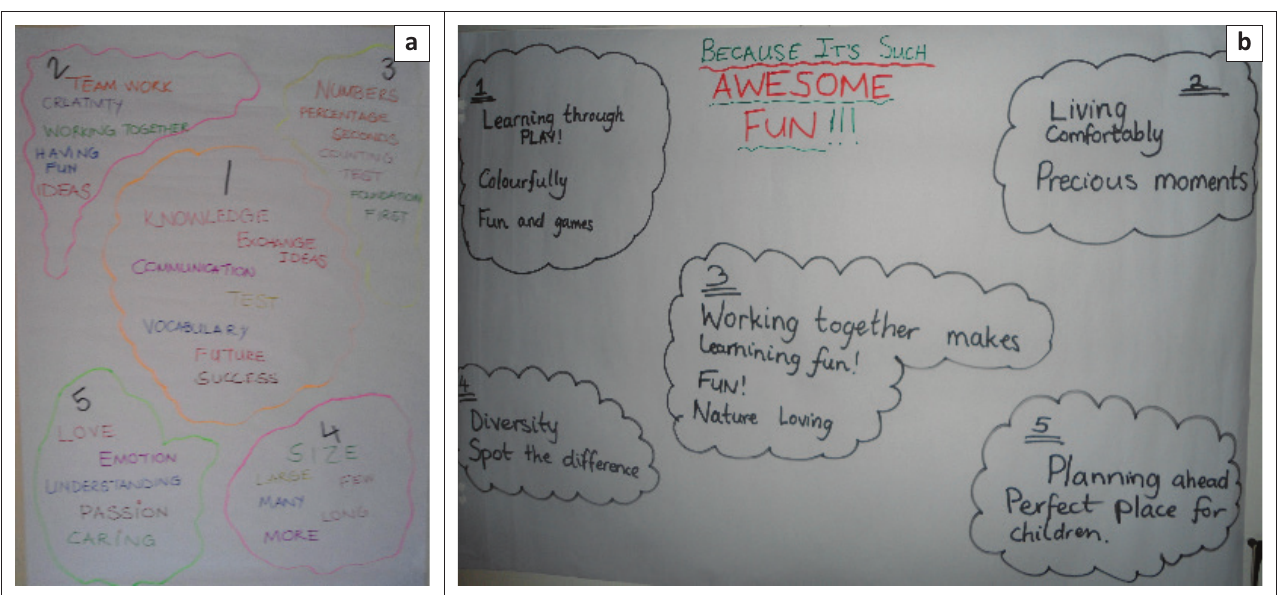
FIGURE 5: Concept maps created by student teachers in a and